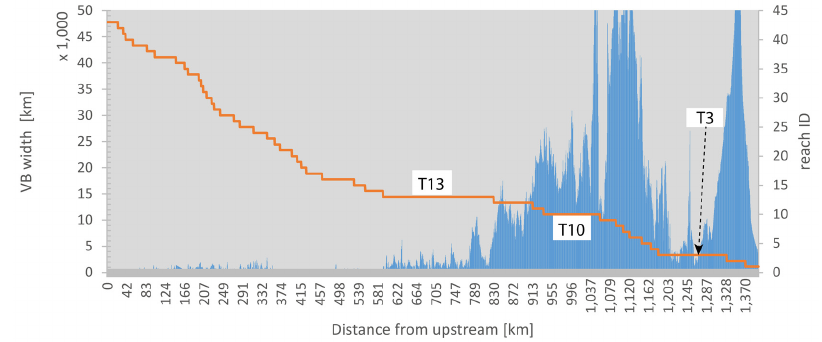
Figure 8. Magdalena case study. Schematic representation of VB width (blue line) along the Magdalena (upstream is on the left) showing different reaches determined with the proposed procedure (orange line, with axis on the right). They range from the first one (T43) to the last one (T1) (their vertical position has no relationship with elevation). Reaches T3, T10, and T13 commented about in the following are located here. VB width values greater than 50 km have been cut (actual max is around 80 km) as they do not change the general understanding, while hiding useful